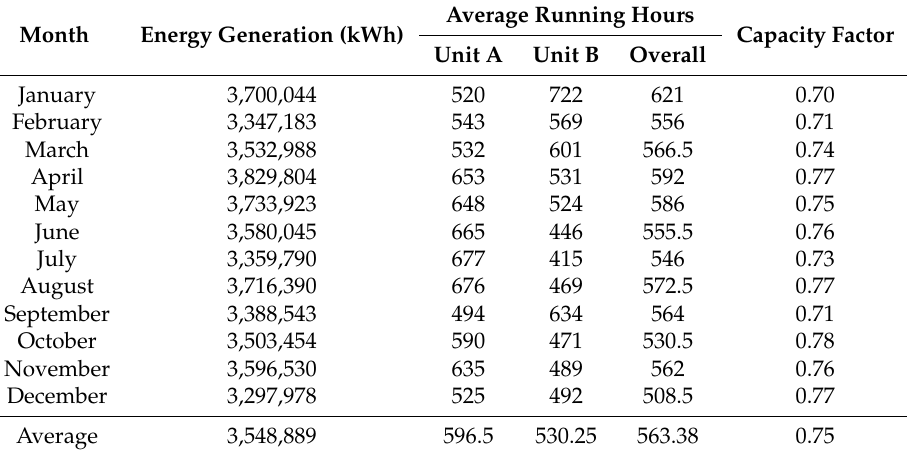
Table 3. Monthly energy generation and running hours of the UTP microgrid (based on the year of